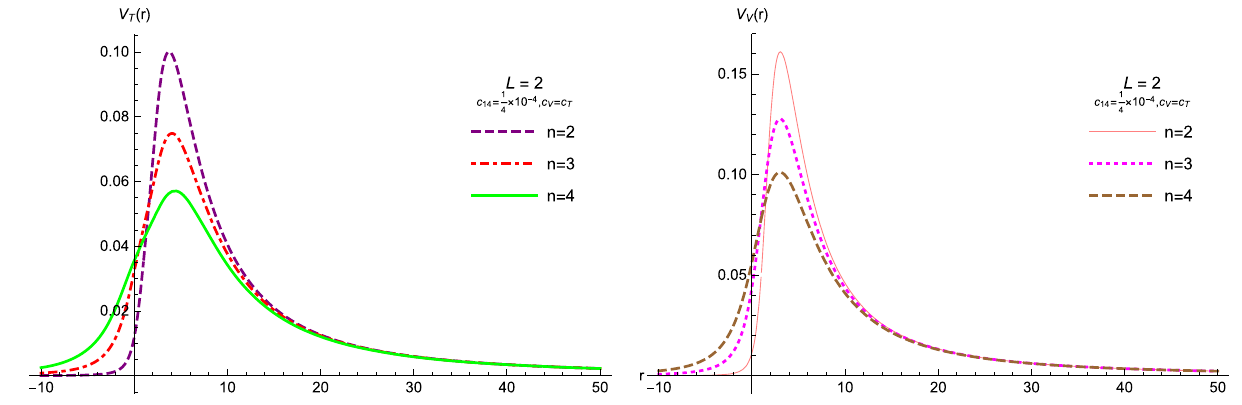
Fig. 2 The effective potentials V T and V V of the axial gravitational and æther perturbations